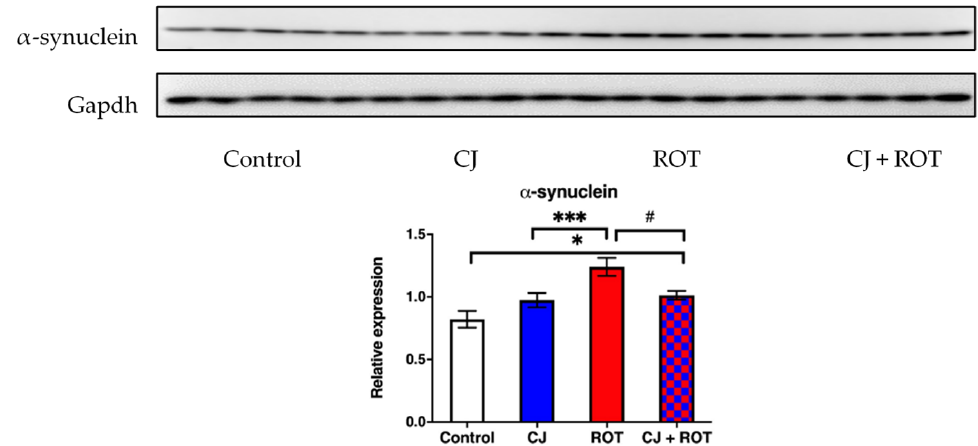
Figure 2. Effect of cranberry juice (CJ) treatment on α -synuclein expression. The top panel shows representative immunoblots. The graph shows the relative expression of α -synuclein normalized to GAPDH ± SEM in the midbrain of rotenone (ROT) injected rats (n = 8/group). Data were analyzed using one-way ANOVA followed by Fischer’s LSD multiple comparisons test. * p < 0.05 vs. Control; *** p < 0.001 vs. Control; # p < 0.05 vs. ROT.